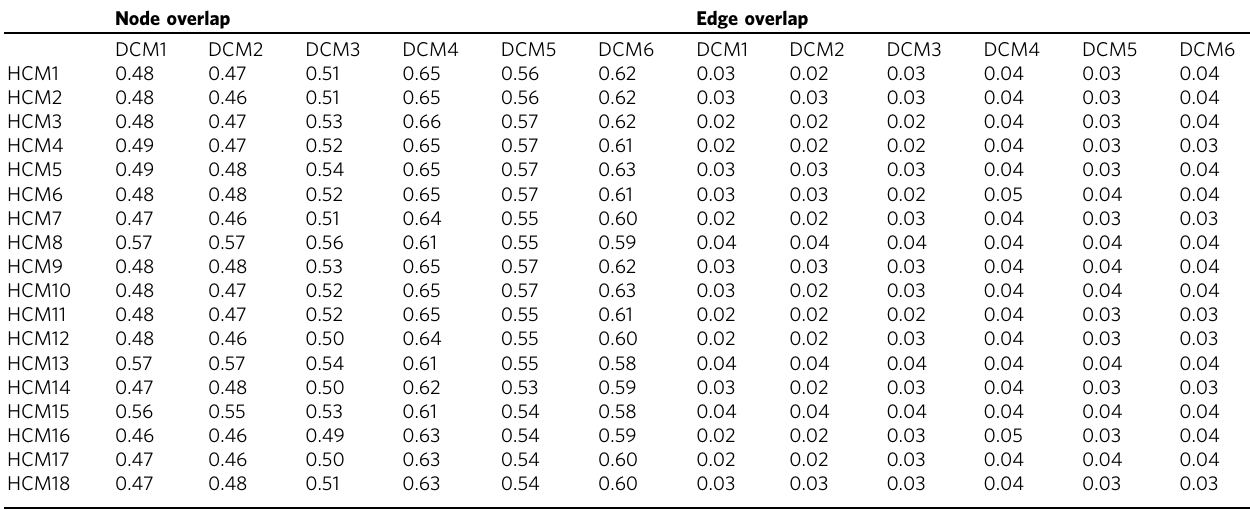
Table 2 Node and edge overlap between individual-patient networks for the HCM and DCM cohorts. Node overlap Edge overlap